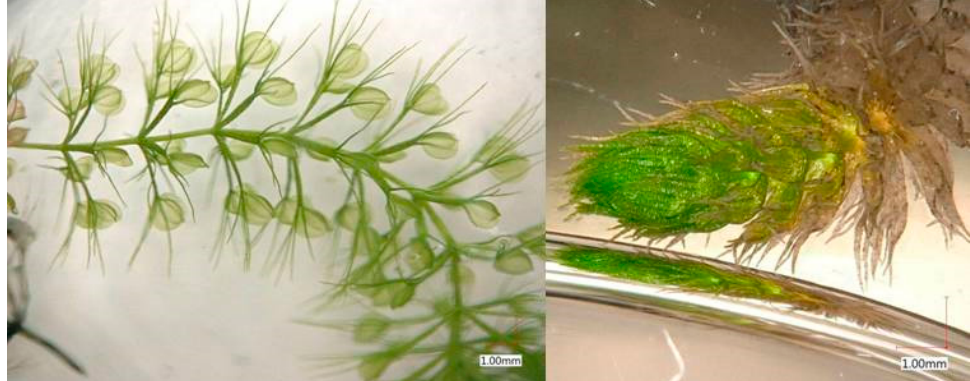
Figure 2. The influence of the AgNPs 1/5 MS media supplementation on the Aldrovanda vesiculosa trap formation in tissue culture.